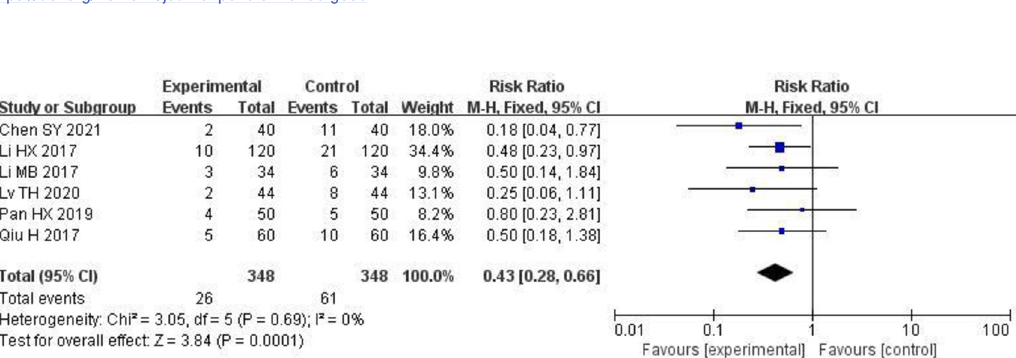
Fig 8. Forest plot of effects of Shenyankangfu tablets and Losartan potassium in the treatment of chronic glomerulonephritis on leukotactin-1.